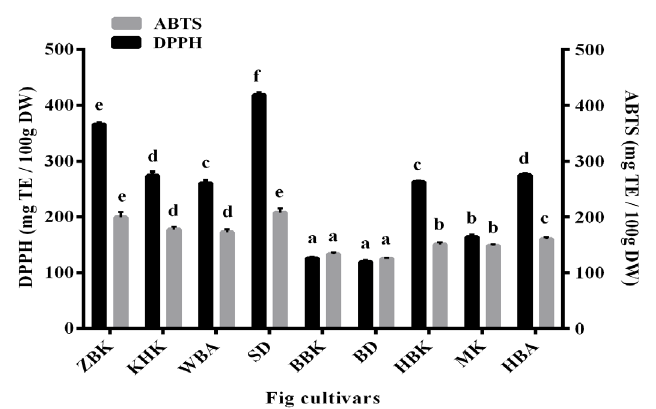
3: The total antioxidant capacity of nine dry fig cultivars using DPPH and ABTS radicals. Data are displayed with mean ± standard de- viation of three replications. Letters above columns represent the groups given by Duncan test (α = 0.05). Different letters indicate significant difference at P < Tab. 2: Correlations between antioxidant capacities by ABTS and DPPH as- says, TPC and TFC of fig cultivars studied. Bold Pearson correlation coefficients are significant at 5% of confidence level.